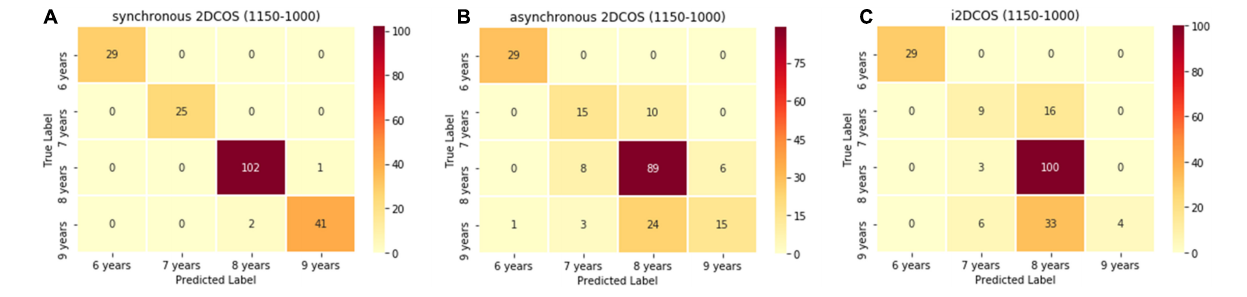
FIGURE 13 | (A) The confusion matrix of synchronous 2DCOS spectra model on the 1,150–1,000-cm − 1 band. (B) The confusion matrix of asynchronous 2DCOS spectra model on the 1,150–1,000-cm − 1 band. (C) The confusion matrix of i2DCOS spectra model on the 1,150–1,000-cm − 1 band.